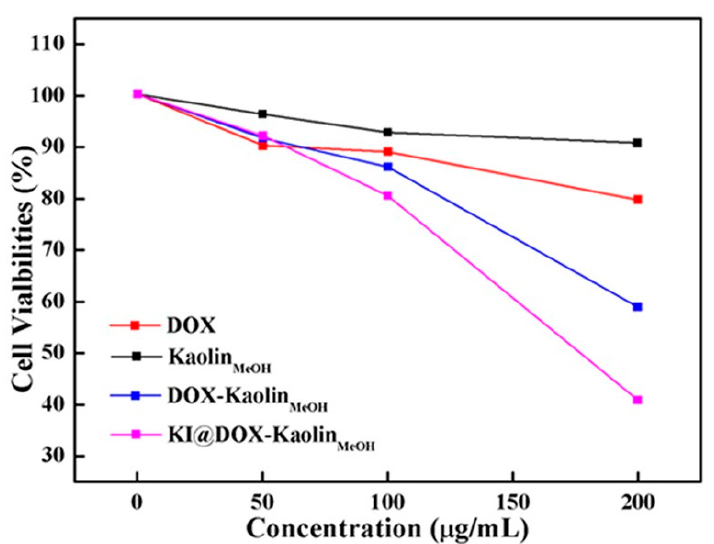
Figure 3. Evaluation of the cytotoxic activity of the different nanoformulations by MTTassay. Papil- lary thyroid carcinoma cell line TPC1 was incubated for 24 h with free DOX, KaolinMeOH, DOX- KaolinMeOH and KI@DOX-KaolinMeOH at different concentrations. Adapted from ref. [53].